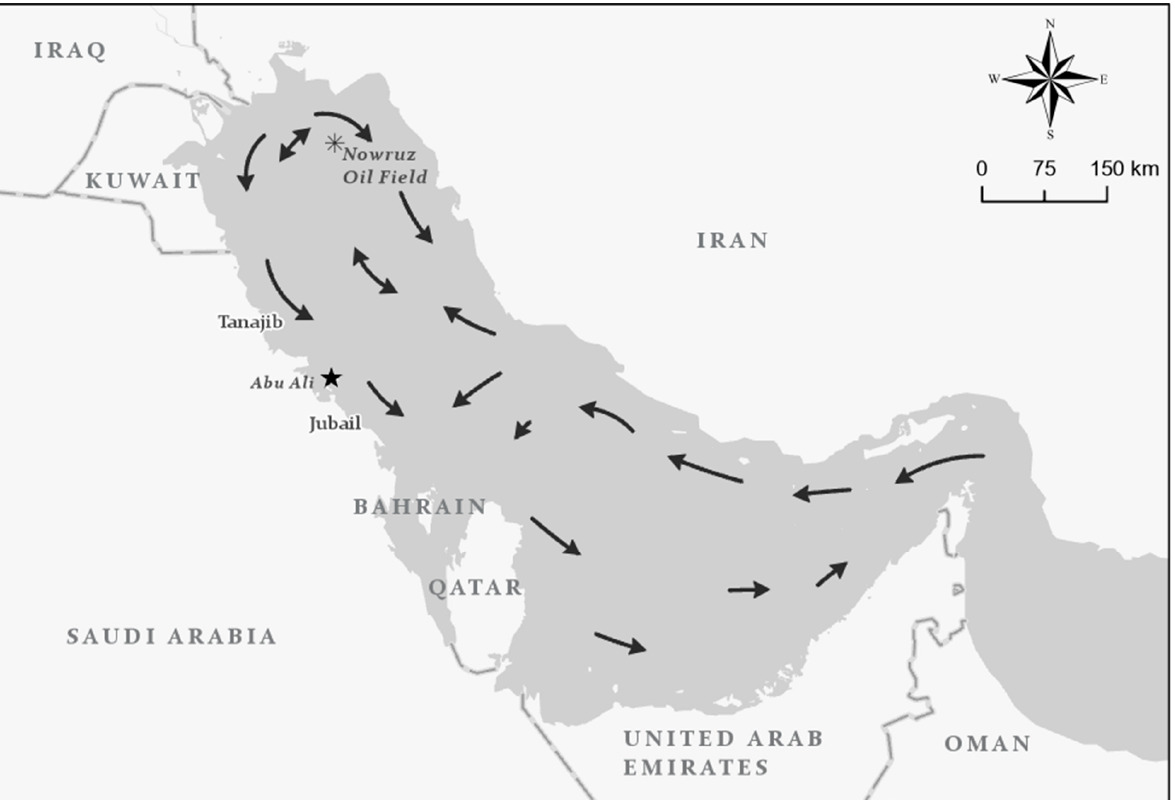
Figure 1. The Arabian (Persian) Gulf showing the location of Abu Ali Island (star), the general sur- face currents (modified from [8]), and the location of the Nowruz oil field